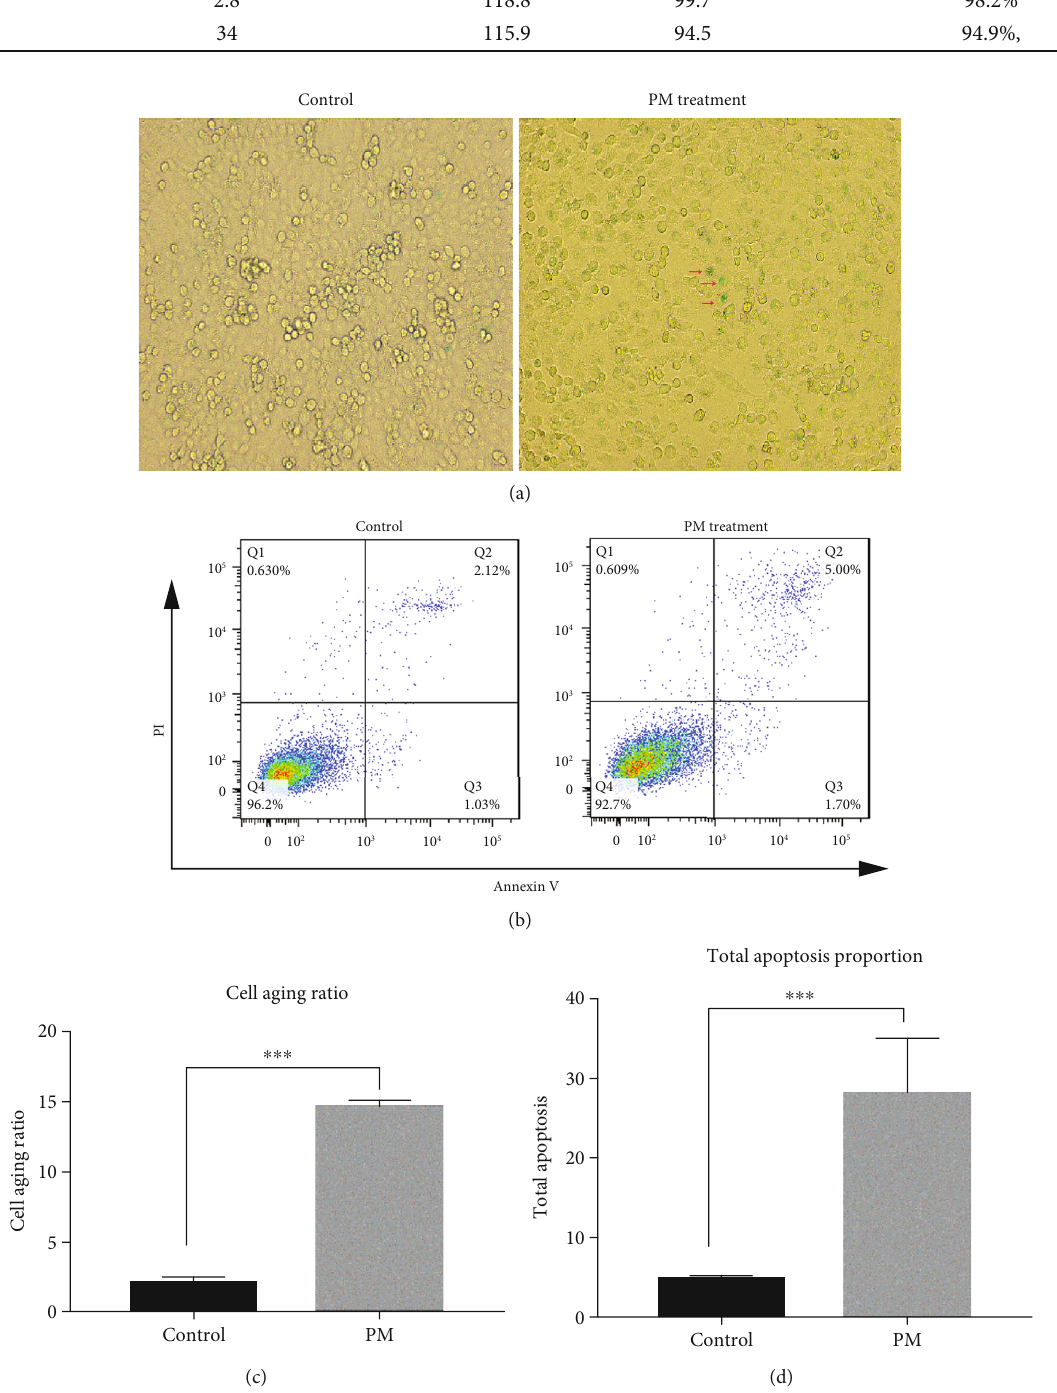
Figure 5: (a, c) The number of dark blue particles in the PM-injured SVOG cells signi fi cantly increased (shown by the red arrows), the proportion of senescent cells in the PM treatment group signi fi cantly increased, and the di ff erence was statistically signi fi cant. ∗∗∗ P < 0 : 001 . (b, d) The proportion of apoptotic SVOG cells (the total apoptosis calculated as ( Q2 + Q3 )) signi fi cantly increased after PM injury, and the di ff erence was statistically signi fi cant. ∗∗∗ P < 0 : 001